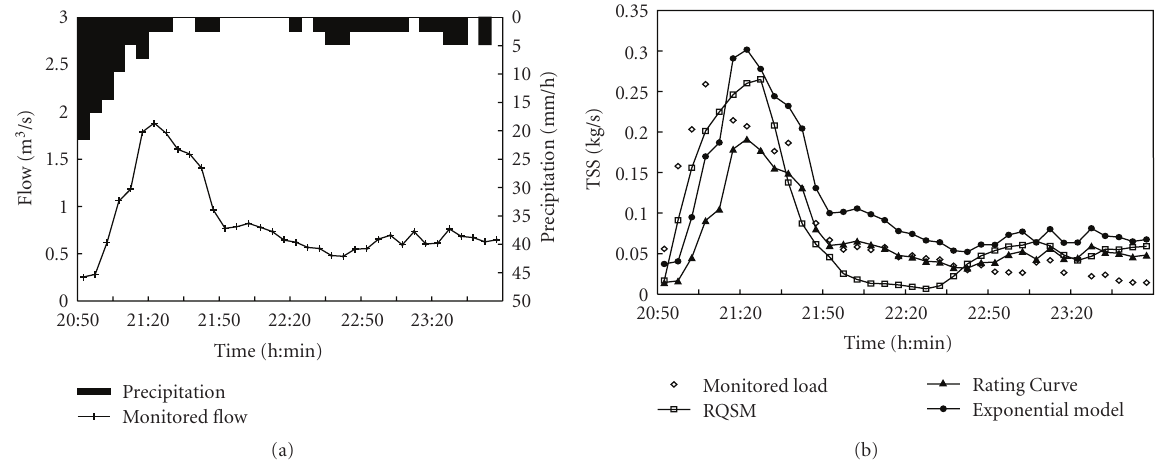
Figure 5: (a) Monitored rainfall and runo ff , and (b) simulated TSS pollutographs for October 13, 2000 rainfall event in the Verdun